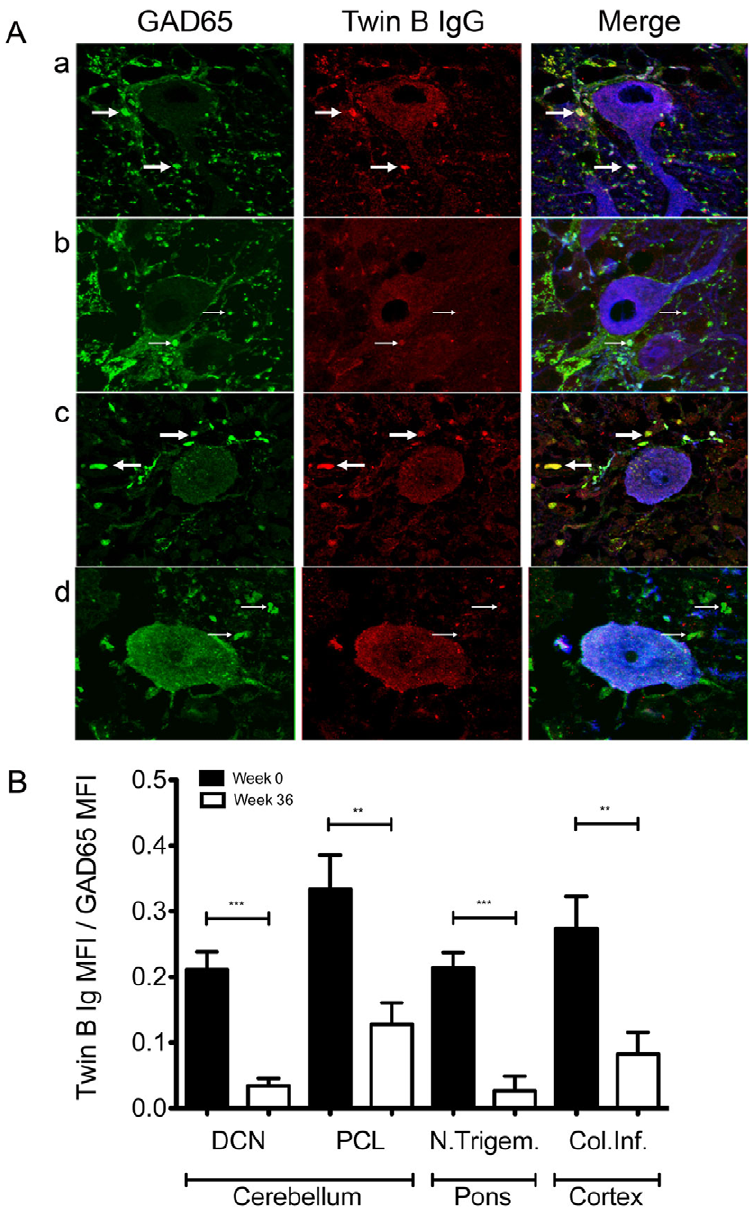
Figure 6. SPS IgG binding to brain structures is sensitive to rituximab treatment. (A) Sections were stained with a reference anti-GAD65 monoclonal antibody, column 1, and IgG of twin B, column 2. Column 3 represents the merged images and anti-calbindin staining (blue). Row a: mouse cerebellum, Purkinje cell layer, t=0. Row b: mouse cerebellum, Purkinje cell layer, t=36 weeks after rituximab treatment. Row c: healthy human cerebellum, Purkinje cell layer, t=0. Row d: healthy human cerebellum, Purkinje cell layer, t= 36 weeks after rituximab treatment. Solid arrows mark GAD positive inhibitory synapses stained with IgG from twin B, thin arrows show presynaptic terminals staining only with the anti- GAD65 monoclonal antibody. Slides were scanned at 1024 6 1024 pixel resolution with a Leica TCS NT confocal microscope, three channel recordings were performed consecutively in Z-series with gaps of 250 nm between the optical slices. Parameters were held constant between recordings of different samples. The stainings are representative for analyses performed with sections from 3 mouse and 3 healthy human samples with immunoglobulin derived both from twin A and B. (B) Differential recognition of brain antigen before and after rituximab treatment. Serial consecutive sections of three mouse brains were stained with IgG of twin B from t=0, twin B IgG week 36. Three fields of four different brain areas were analyzed per mouse. Fluorescence signal intensities were examined by 10 linear measurements for a total of 600 m m per brain area and corrected for background staining. For each the ratio between twin B IgG fluorescence intensity and anti-GAD65 monoclonal antibody fluorescence intensity was calculated. Data represented are subtracted from the HD signals in the specific areas. Significant differences in staining were determined with unpaired two-tailed T test (*** , 0.0001; ** , 0.001; * , 0.05).